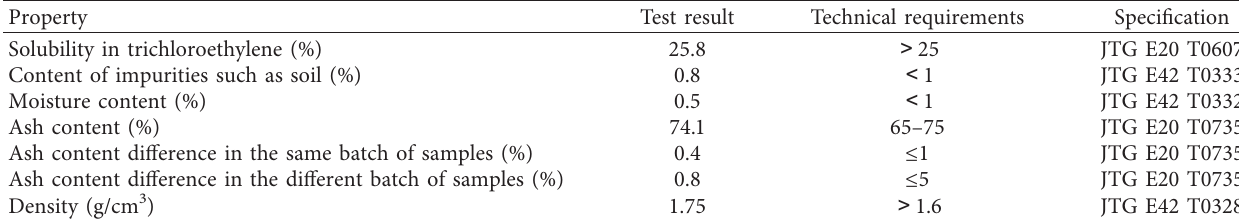
Table 2: Technical properties of Buton rock